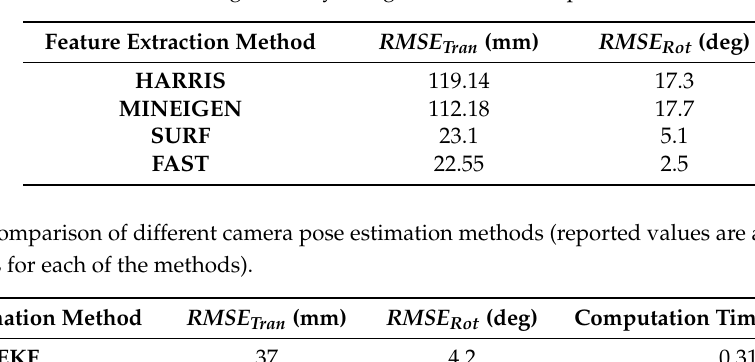
Figure 7. RMSE of ( a ) Translation part; ( b ) rotation part of camera pose against number of particles used in PF. Table 2. Tracking accuracy using different feature point detectors.